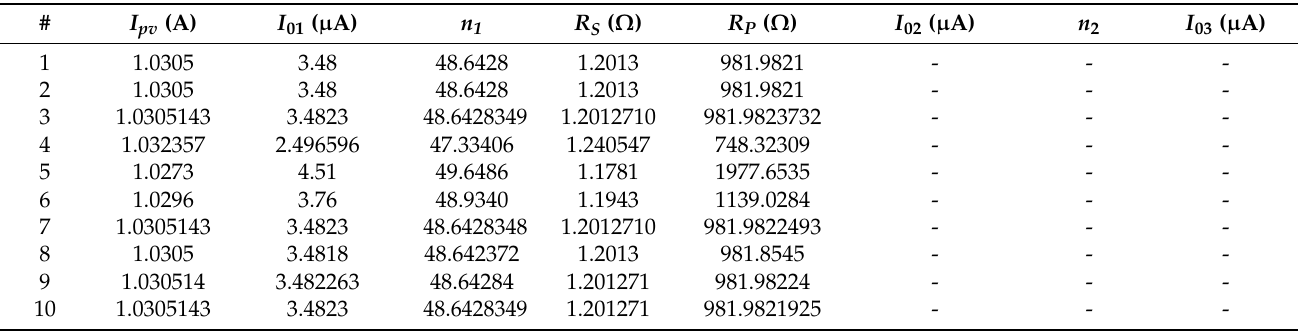
Table 6. Parameters of the equivalent circuit models of the Photowatt-PWP201 module using the methods presented in Table